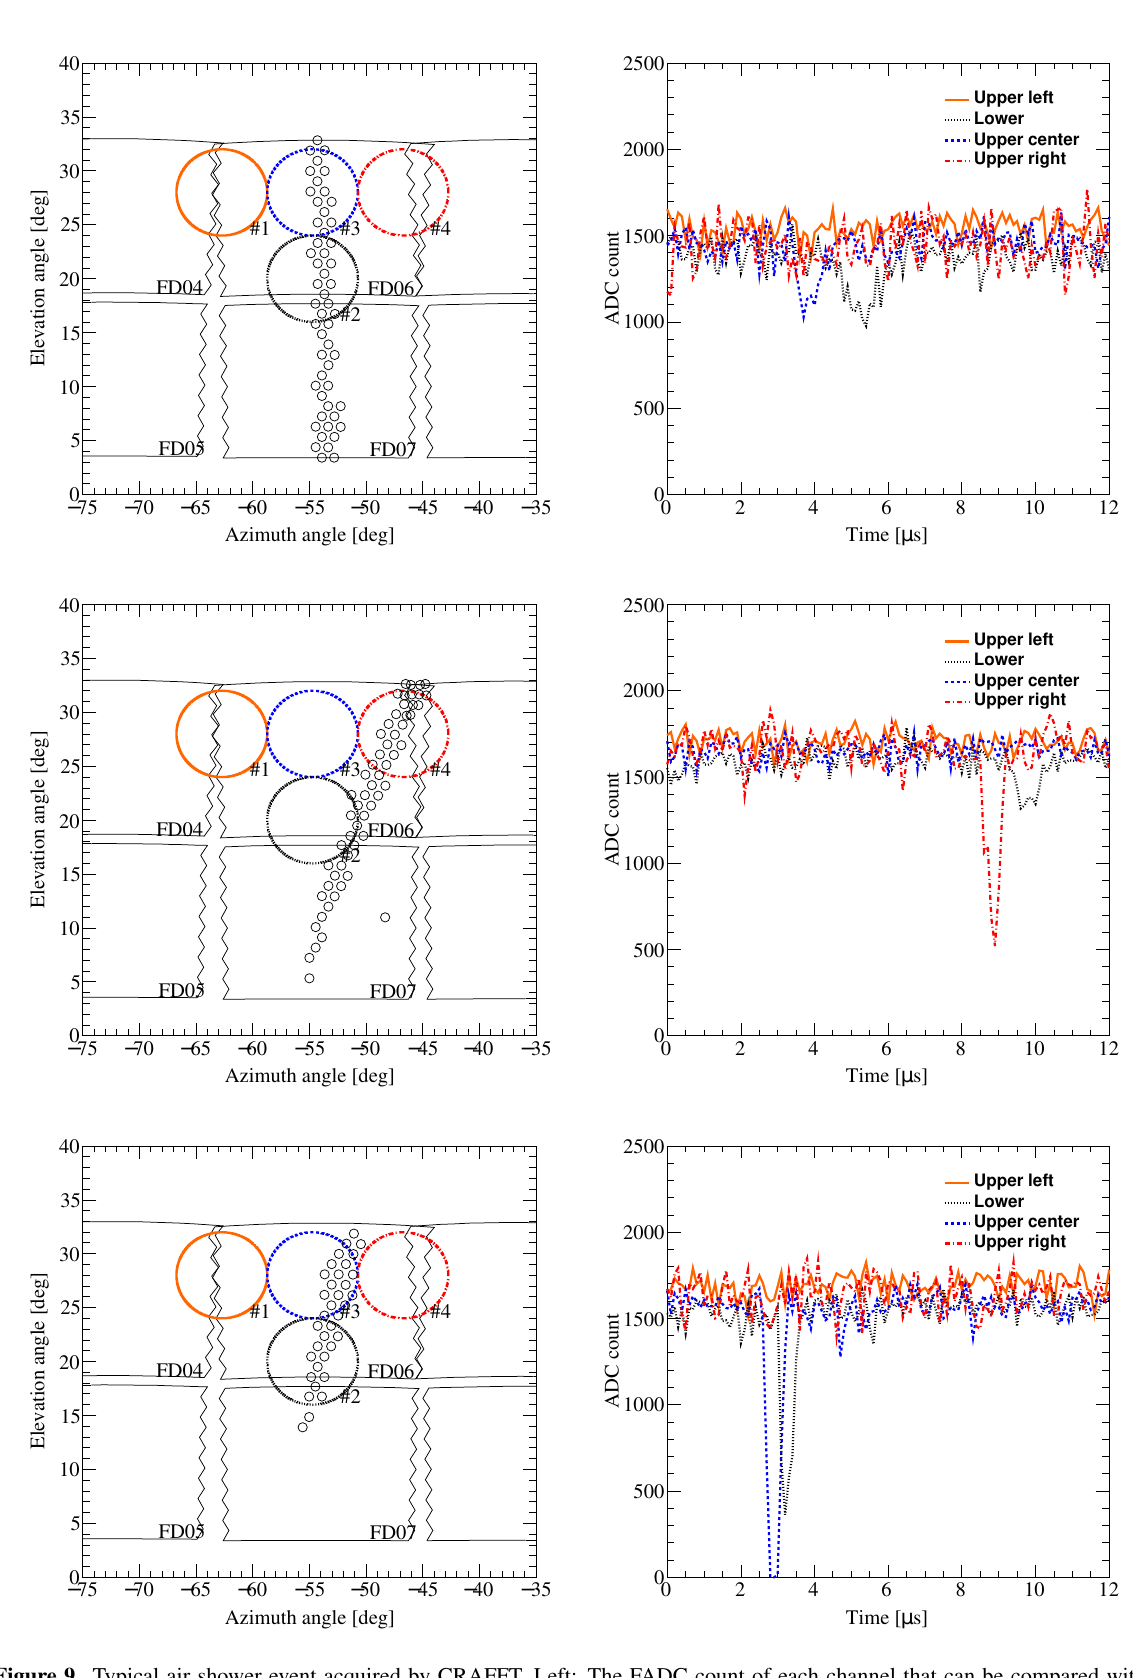
Figure 9. Typical air shower event acquired by CRAFFT. Left: The FADC count of each channel that can be compared within the accuracy of 20%. Right: TA FD event display. Solid line is the edge of TA FD F.O.V. 1 ◦ circles are views of TA FD triggered channels. 8 ◦ circles are the F.O.V. of